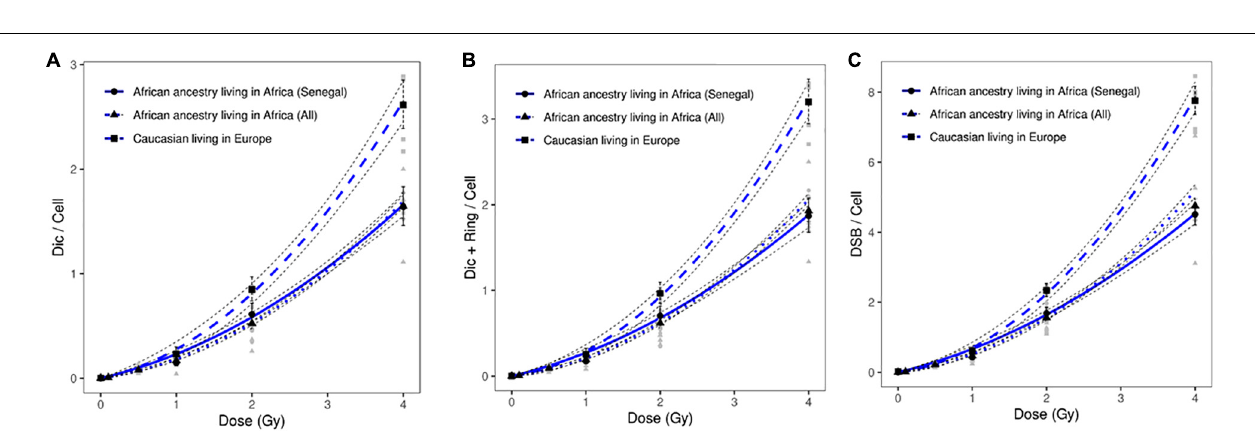
FIGURE 3 | Dose response curves obtained after X-ray irradiation of circulating lymphocytes in vitro of healthy donors of all African ancestry living in Africa (Senegal, Benin, Burkina Faso and Burindi) and European ancestry living in Europe after scoring of (A) dicentric chromosomes, (B) dicentric and ring chromosomes, and (C) calculated DSBs. The mean numbers of chromosomal aberrations with 95% confidence intervals of each population are shown. Individual values for each of the donors are also plotted, as well as the standard errors (dotted line). No significant difference was observed between the dose response curve obtained healthy Senegalese donors and all healthy African